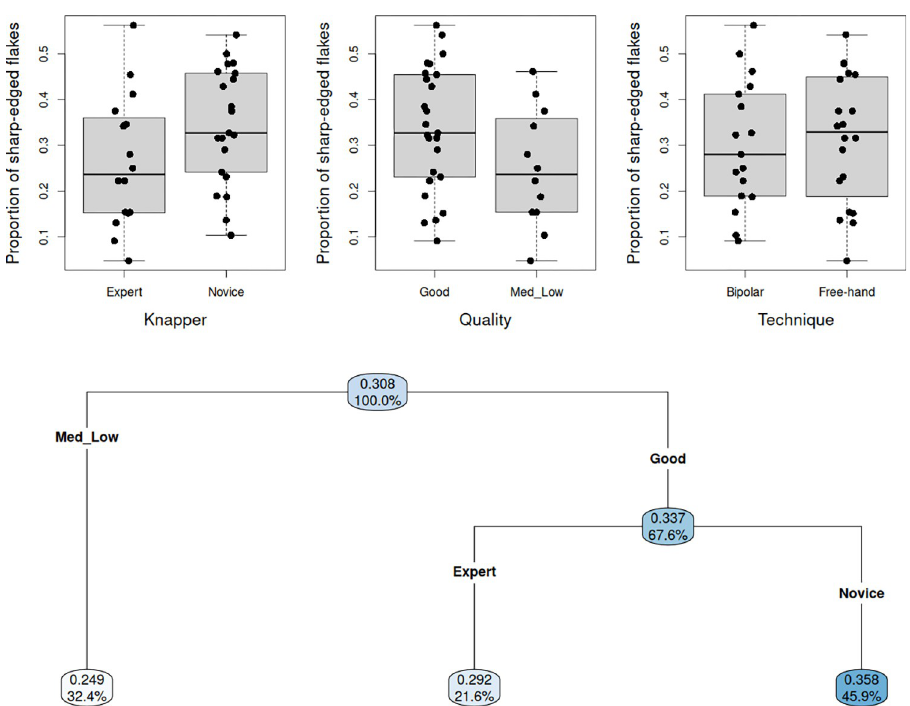
Fig 5. a. Boxplots and stripcharts for the impact of each factor on the proportion of sharp-edged flakes; b. Regression tree for the proportion of sharp-edged flakes, with knapping technique, raw material quality and knapping expertise as covariates. (In each node, the upper value is the empirical proportion observed for a given combination of experimental conditions; the "%" value indicates the percentage of the total sample size in this node).